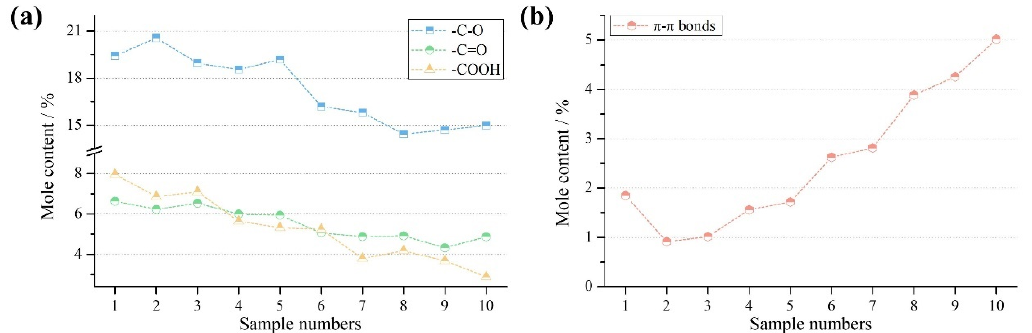
Figure 9. Fitting results of the XPS spectra, ( a ) mole content distribution of the three types of functional groups, ( b ) distribution of π – π bonds.